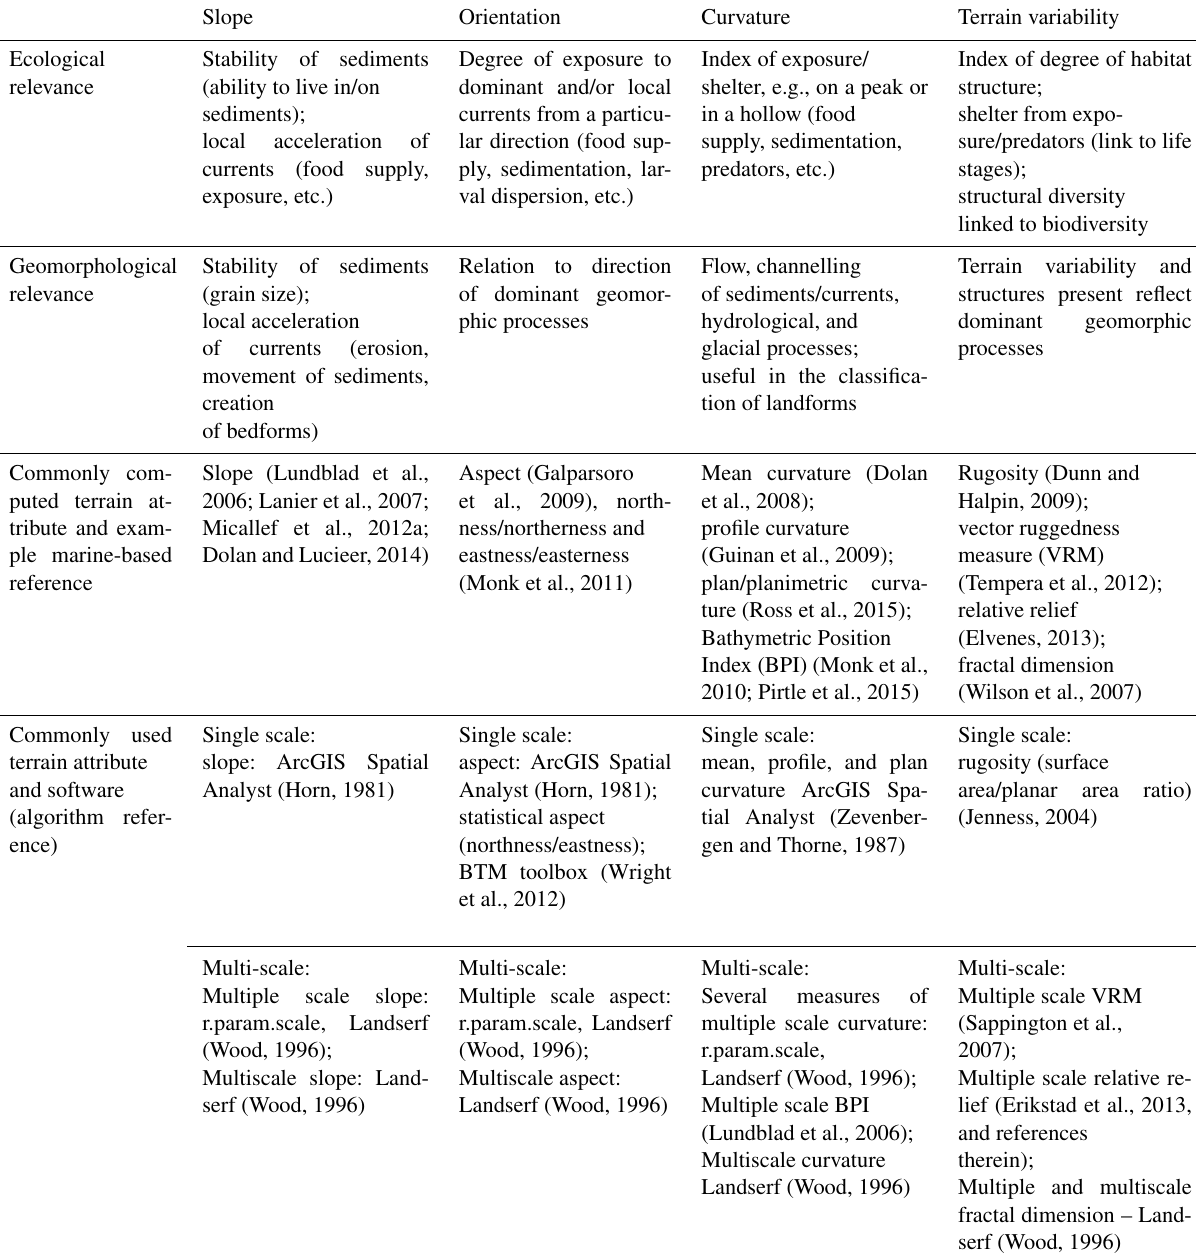
Table 1. Summary of the most commonly used terrain attributes in marine-based studies, as well as an indication of some common calculation approaches. Modified after Dolan et al. (2012). The term “multiple scale” refers to terrain attributes derived in turn using analysis windows of different sizes. “Multiscale” refers to indices derived simultaneously over a range of window sizes. The more general term “multi-scale” is used in this paper to refer to both types of analysis as well as geomorphometric analysis using data of different